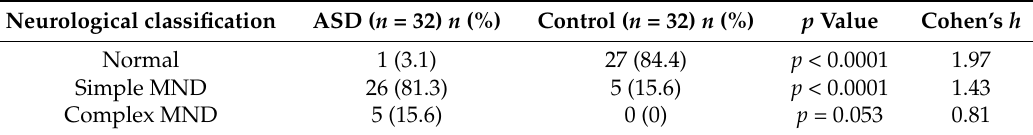
Table 1. Prevalence of MND in ASD and control children.